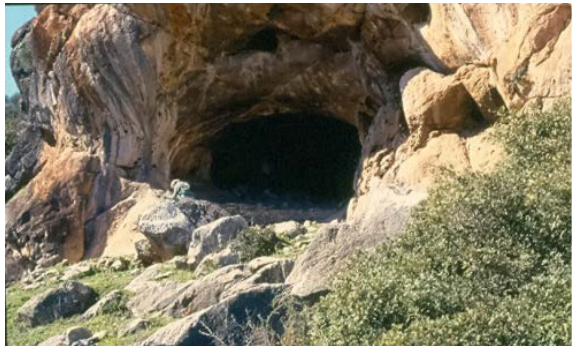
Figure 2. Kef El Baroud cave (photo Searight).